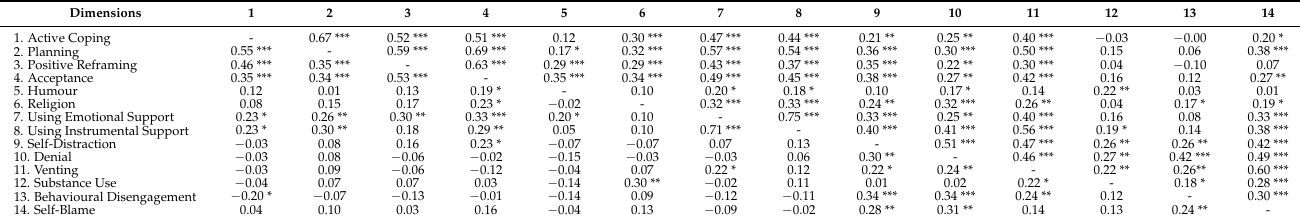
Table 4. Brief COPE correlation matrixes between its dimensions among community ( n = 136) and at-risk sample ( n = 116).